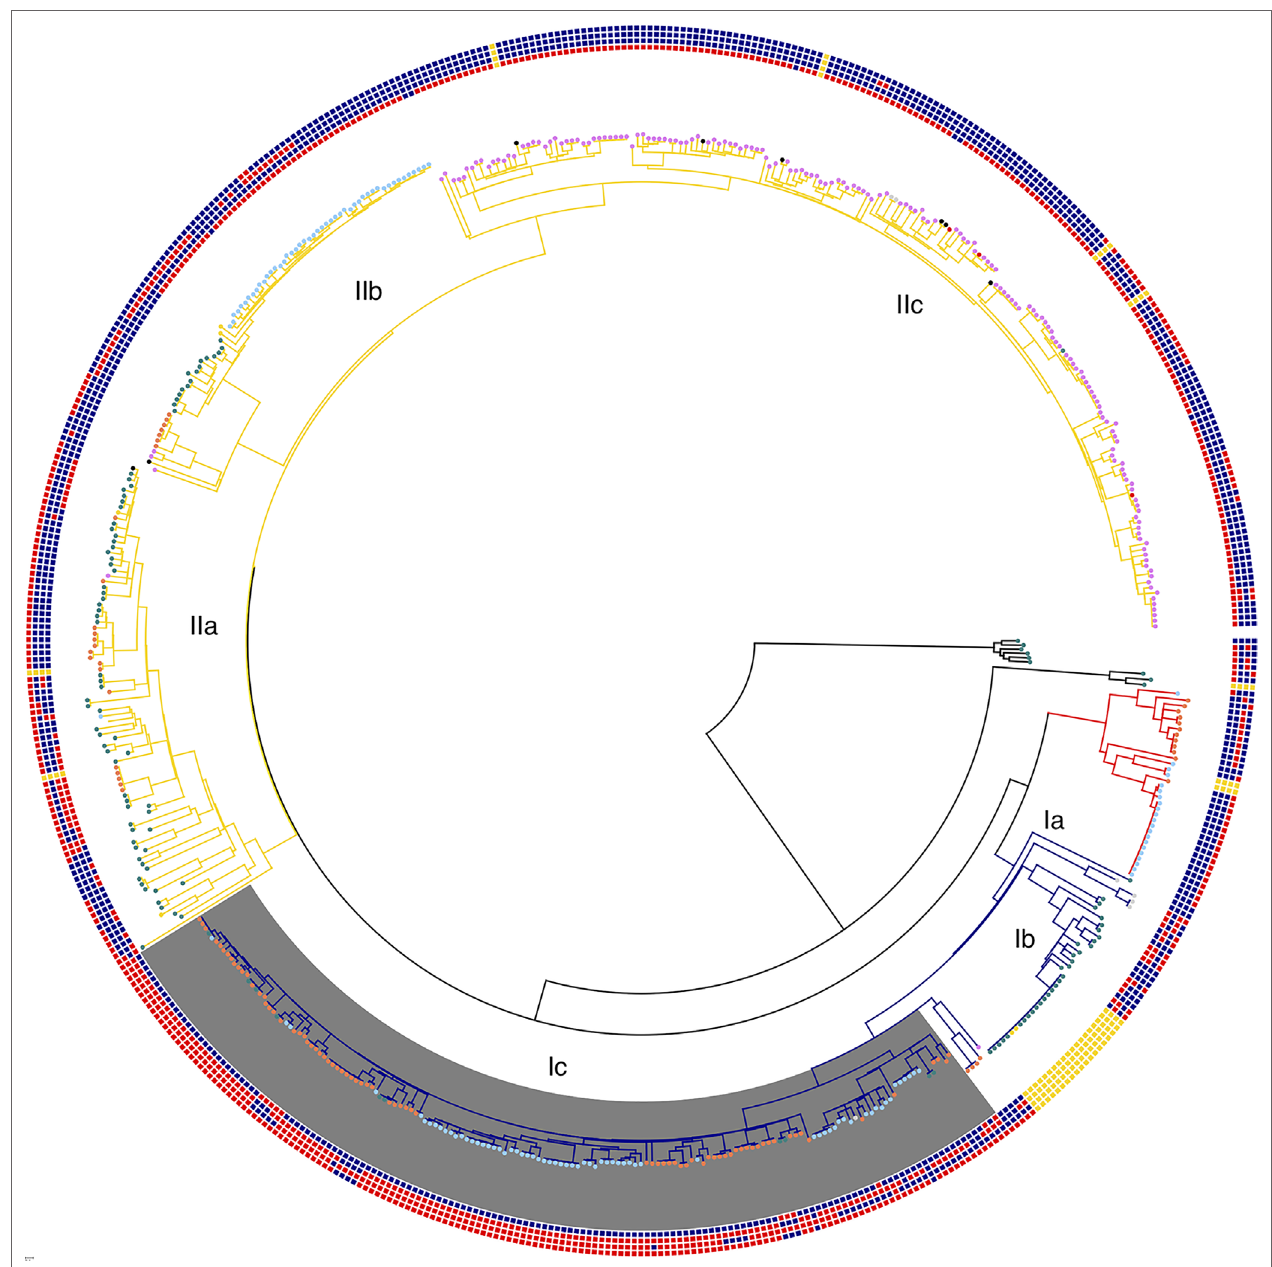
FIGURE 1 | Phylogenetic tree displaying all clinical cases of STEC O157 from the UK in 2017 ( n = 580) ( Supplementary Table 1 ). Clades are labeled by color (clade I—blue, clade I/II—red, clade II—yellow). Phage resistance phenotypes are labeled as colored squares concentrically around the outside in the following order: T7 coliphages, Group 1 T4 coliphages, Group 2 T4 coliphages, and Group 3 T4 coliphages (Cowley et al., 2015). Red signifies resistance, blue signifies susceptibility, and yellow signifies no information. OmpC allele with C at position 921 instead of T highlighted in gray. Nodes are labeled by stx profile. Violet signifies stx2c stx1a, blue signifies stx2a, green signifies stx2c, orange signifies stx2a stx2c, red signifies stx1a, black signifies stx2a stx2c stx1a, and gray signifies stx2a